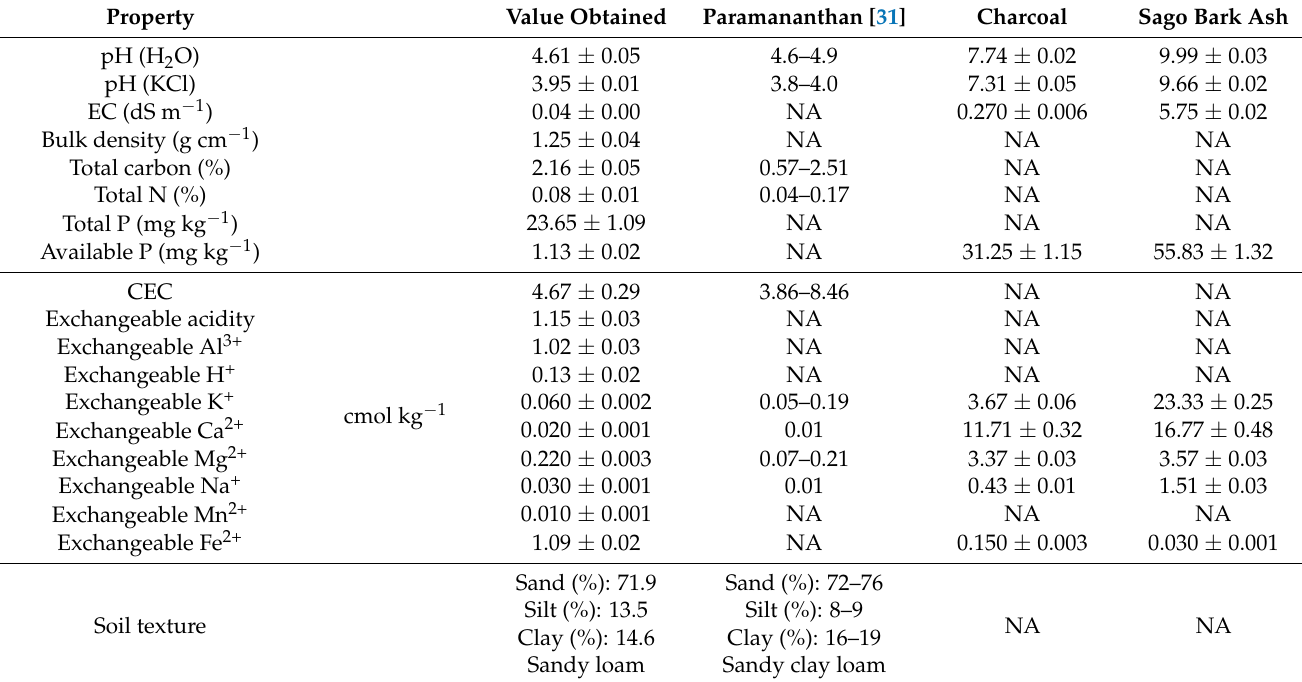
Table 1. Initial characterization of the Bekenu Series ( Typic Paleudults ), charcoal, and sago bark ash. Property Value